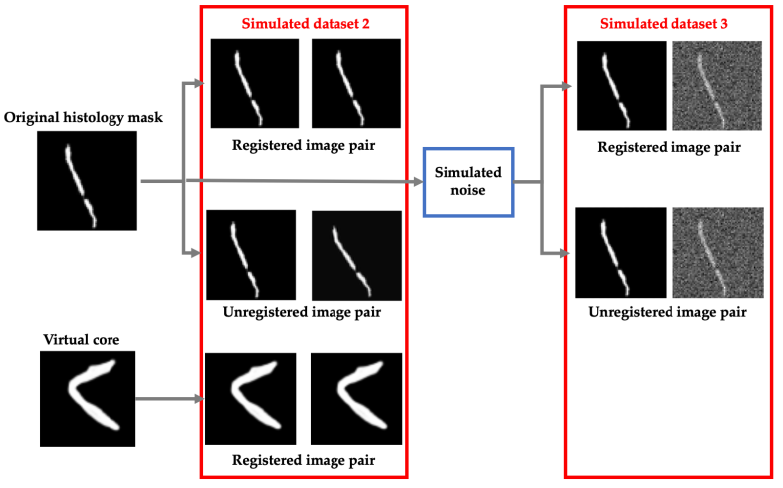
Figure 5. Left — Data simulation approach for generating unimodal and virtual registered and unregistered image pairs. Right — Data simulation approach for generating multi-modal registered and unregistered image pairs.